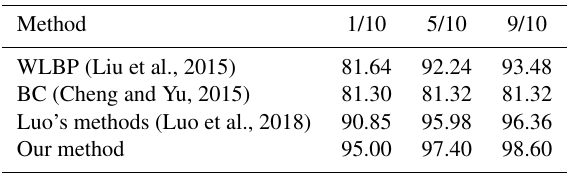
Table 2. Classification accuracy (%) of the zenithal dataset obtained by different